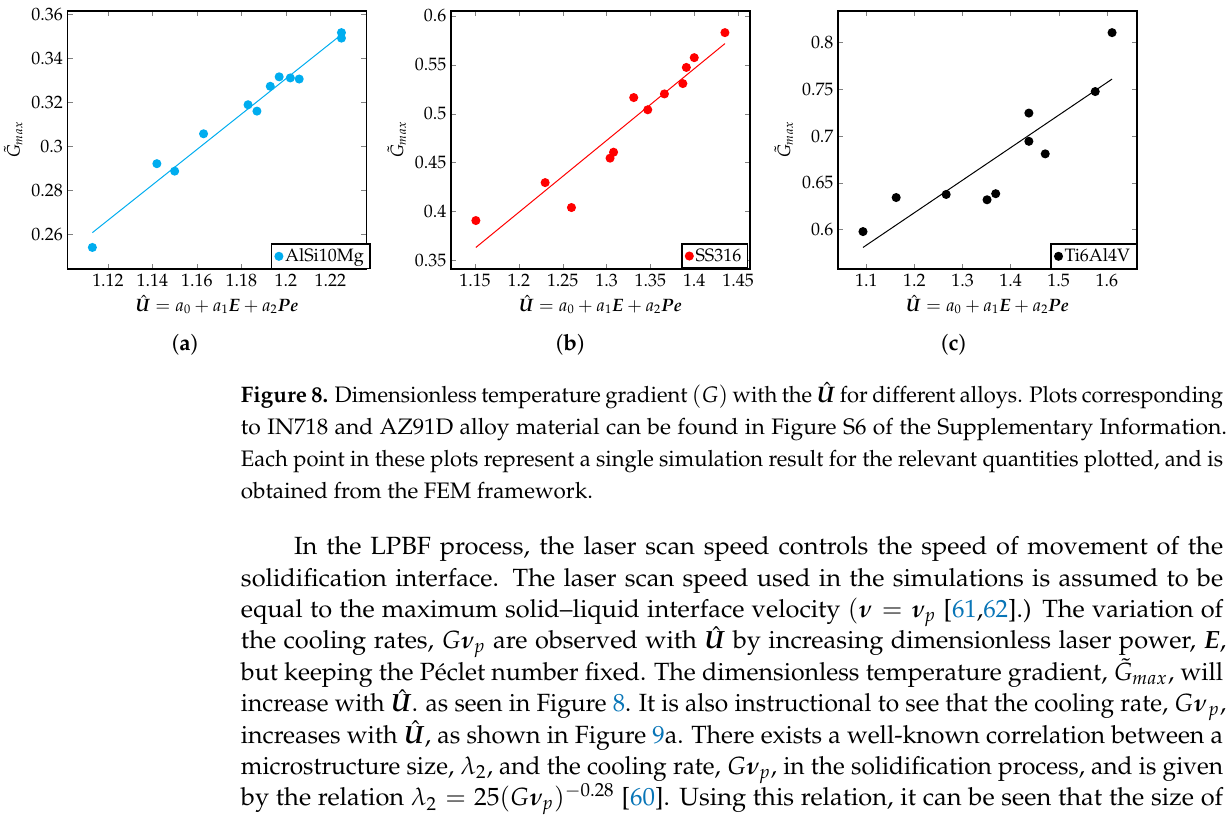
Figure 7. Correlation of the meltpool volume ( l m w m d m ) with Ste ˆ U plotted on a log–log scale, for ( a ) AlSi10Mg, ( b ) SS316, and ( c ) Ti6Al4V alloys. Corresponding plots comparing IN718 and AZ91D alloys, and a comparison of all the five alloys considered in this work can be found in Figure S4 and S5 of the Supplementary Information, respectively. Each point in these plots represent a single simulation result for the relevant quantities plotted, and is obtained from the FEM framework.